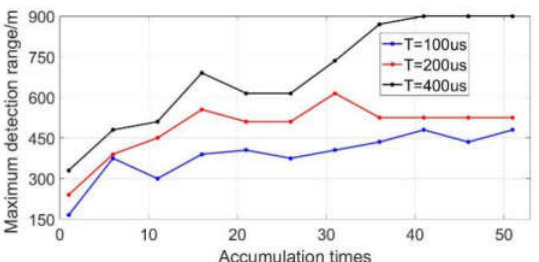
Figure 4 The relationship between the maximum detection range and the accumulation times under variable sequence length